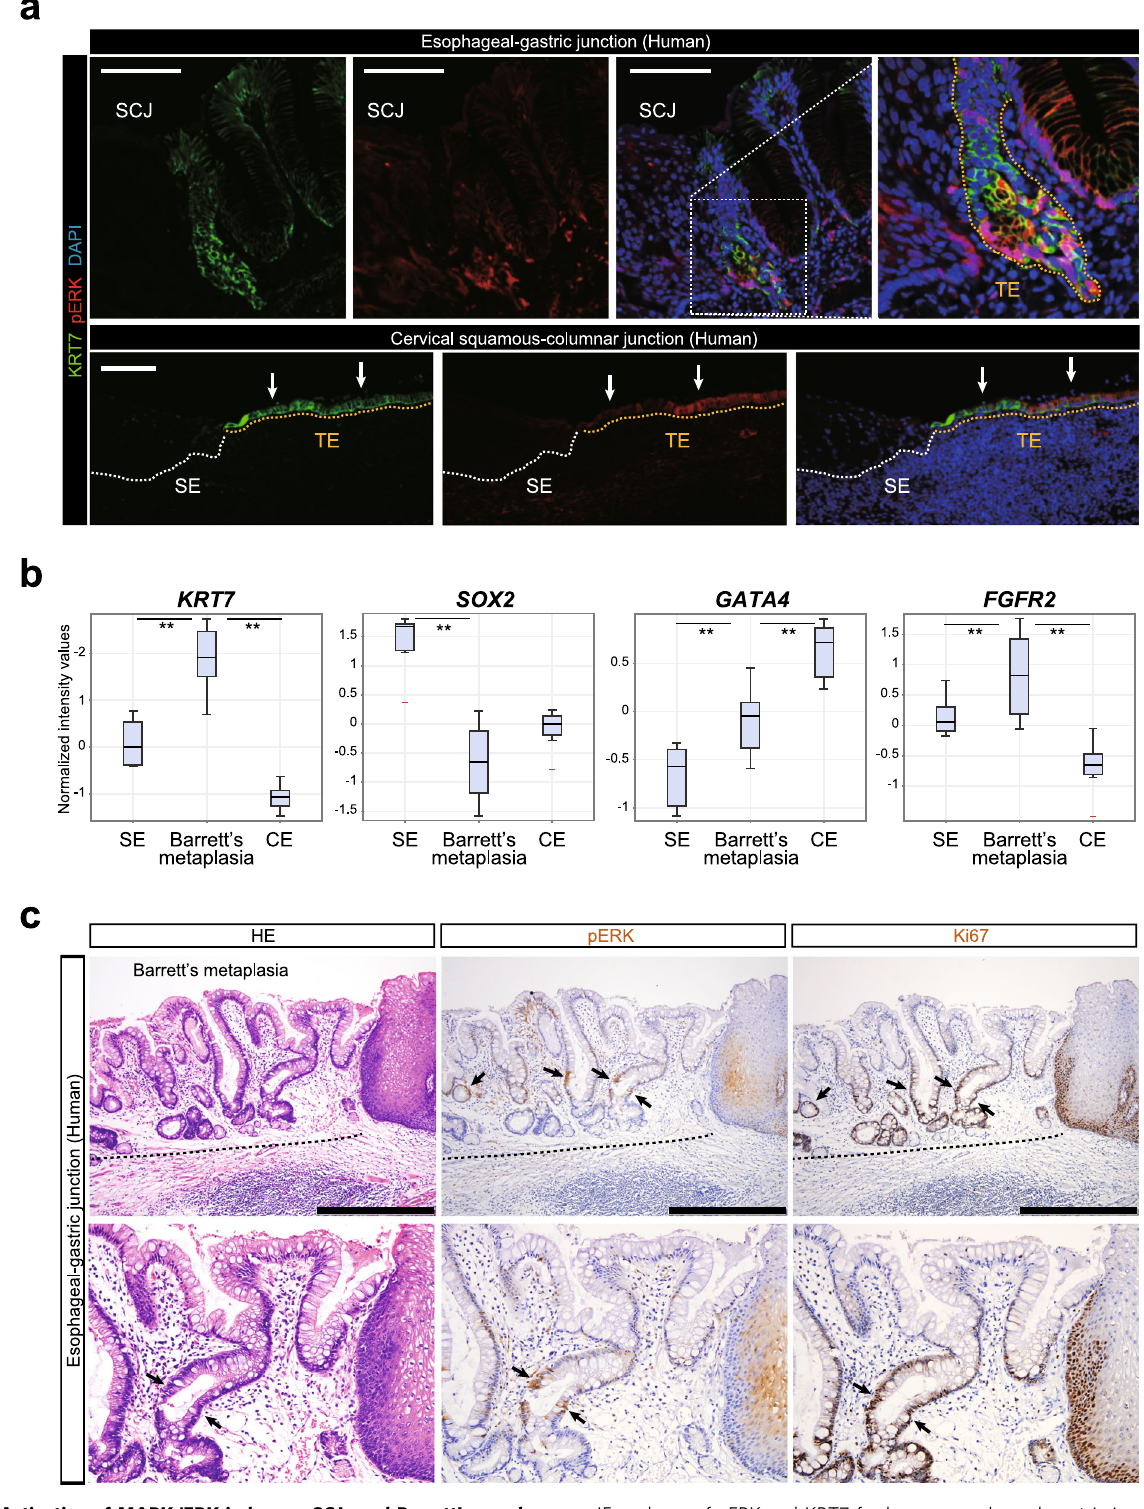
Fig. 7 Activation of MAPK/ERK in human SCJs and Barrett ’ s esophagus. a IF analyses of pERK and KRT7 for human esophageal – gastric junction and uterine cervix. Arrows indicate the pERK + KRT7 + transitional epithelial cells. SE squamous epithelium, TE transitional epithelium. Presented data are a representative image of n = 4. Scale bar, 100 µ m. b Expression levels analyses of KRT7 , SOX2 , GATA4 , and FGFR2 for esophageal squamous epithelium (SE) ( n = 8), gastric columnar epithelium (CE) ( n = 10), and Barrett ’ s metaplasia ( n = 10). Raw data are extracted from GEO record GSE34619. Solid lines in each box indicate the median. Bottom and top of the box are lower and upper quartiles, respectively. ** p < 0.01, one-way ANOVA. c H&E staining (left) and IHC analyses of pERK (middle) and Ki67 (right) in human Barrett ’ s metaplasia. Arrows indicate pERK + Ki67 + cells. Top: ×10 magni fi cations. Bottom: ×20 magni fi cations. Presented data are a representative image of n = 4. Scale bar, 500 µ m.